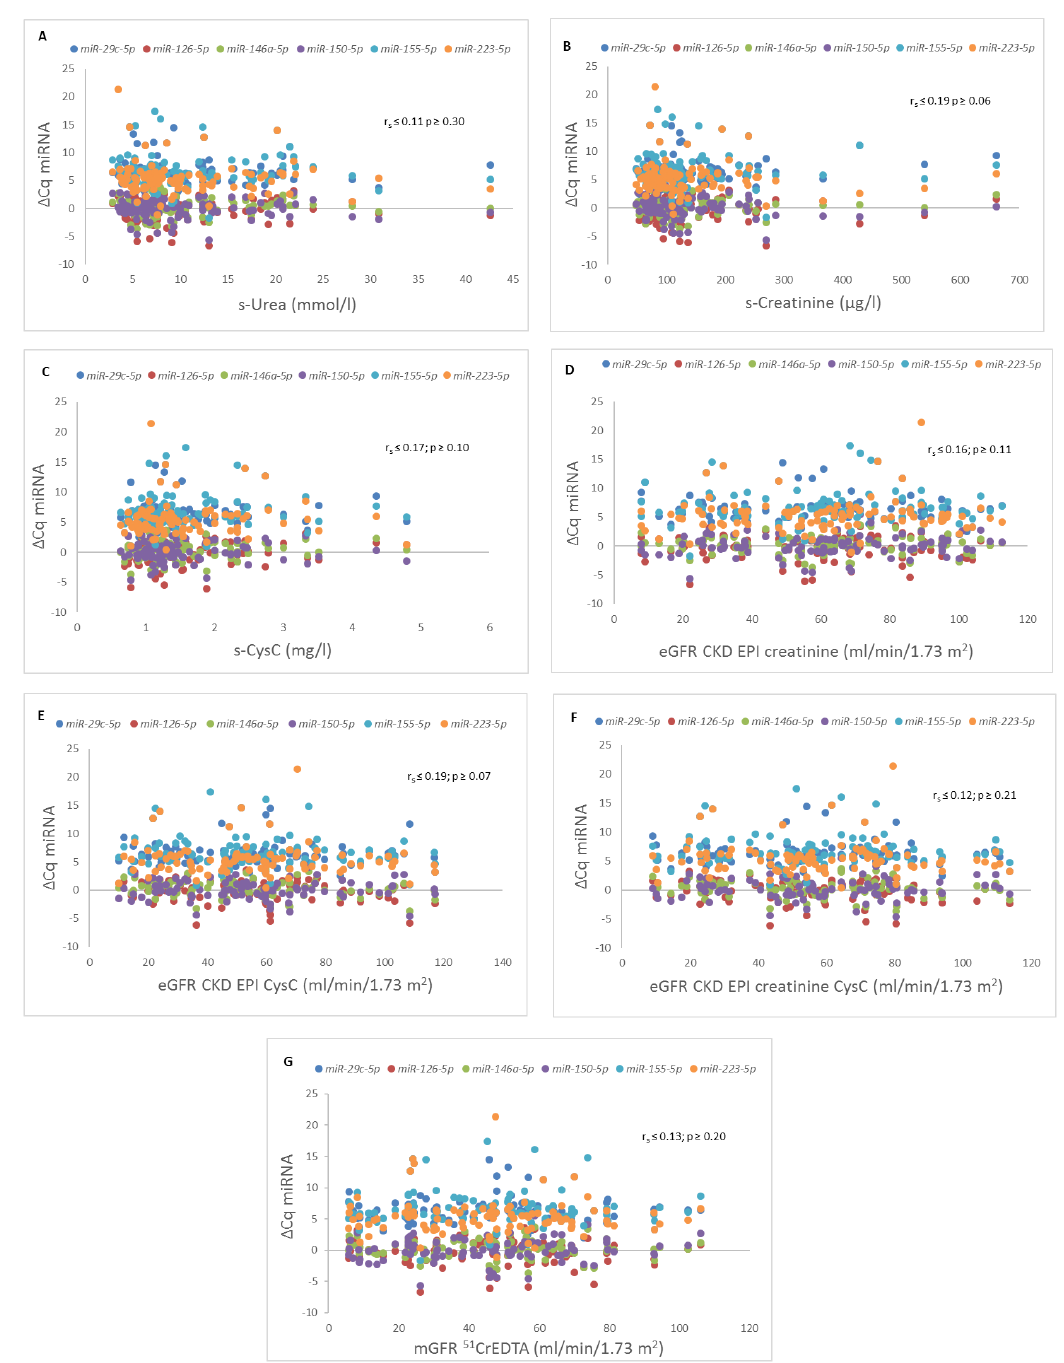
Figure 3. Correlations between di ff erent microRNAs (miRNAs) and parameters of kidney graft function. Correlation between di ff erent miRNAs and ( A ) serum urea concentration (s-Urea), ( B ) serum creatinine concentration (s-Creatinine), ( C ) serum cystatin C concentration (s-CysC), ( D ) estimated glomerular filtration rate with Chronic Kidney Disease Epidemiology Collaboration study formula with s-Creatinine (eGFR CKD EPI creatinine), ( E ) estimated glomerular filtration rate with Chronic Kidney Disease Epidemiology Collaboration study formula with s-CysC (eGFR CKD EPI CysC), ( F ) estimated glomerular filtration rate with Chronic Kidney Disease Epidemiology Collaboration study formula with s-Creatinine and s-CysC (eGFR CKD EPI creatinine CysC), ( G ) measured glomerular filtration rate with Chromium-51-ethylenediaminetetraacetic acid clearance (mGFR 51